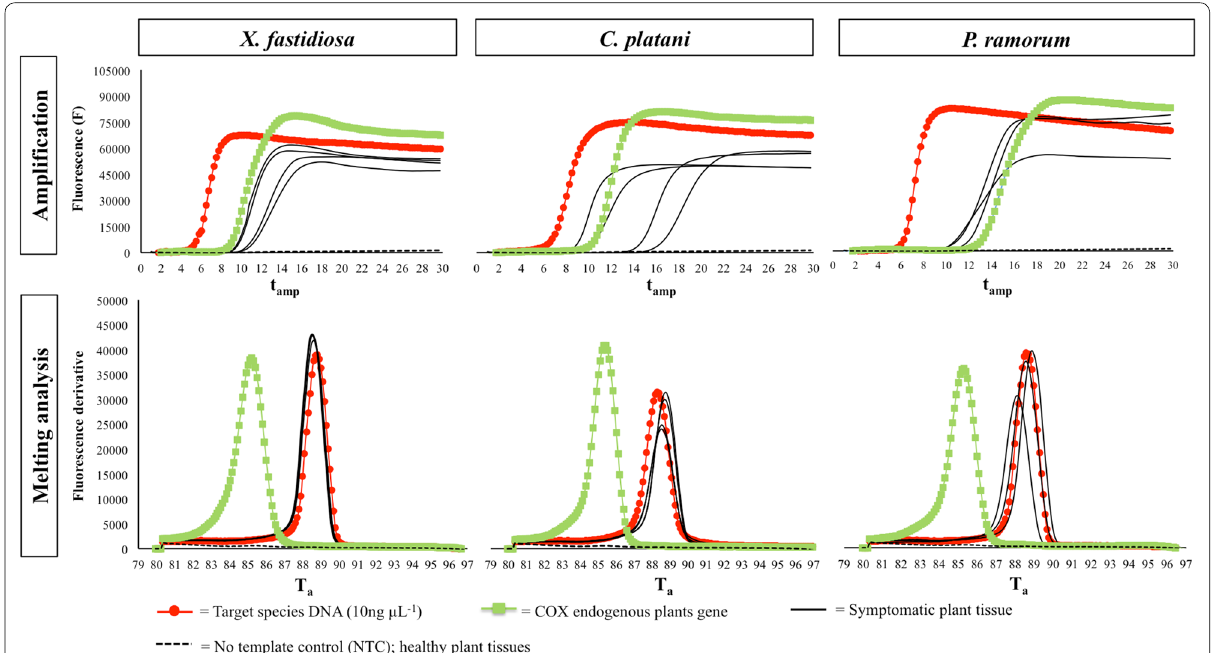
Fig. 1 Selection of kinetics. Real time LAMP results reported as amplification and melting derivative plot for Xylella fastidiosa , Ceratocystis platani and Phytophthora ramorum including target species DNA (10 ng μL − 1 ) in red, COX endogenous plant gene (green) and symptomatic plant tissues (black continuous line). No template control (NTC) and healthy plant tissue were also included (black dotted line). T a annealing temperature, t amp amplification time